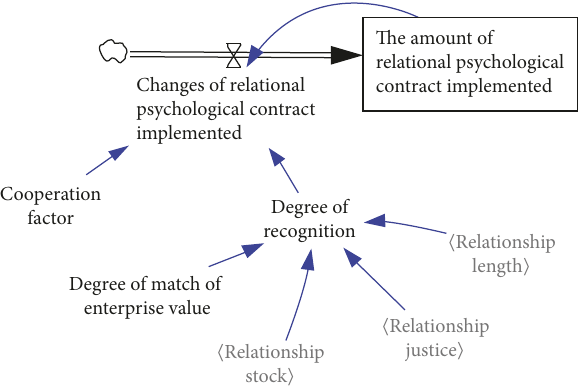
Figure6:Changesofrelationalpsychologicalcontractimplemented (CRPCI) rate variable in-tree